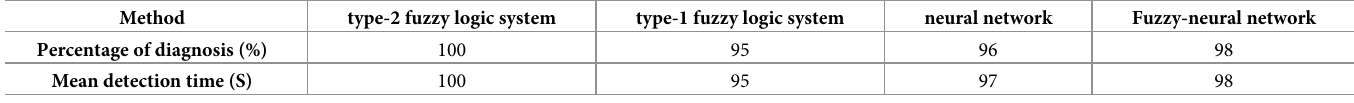
Table 4. Comparison of percentage of detection by different methods in scenario